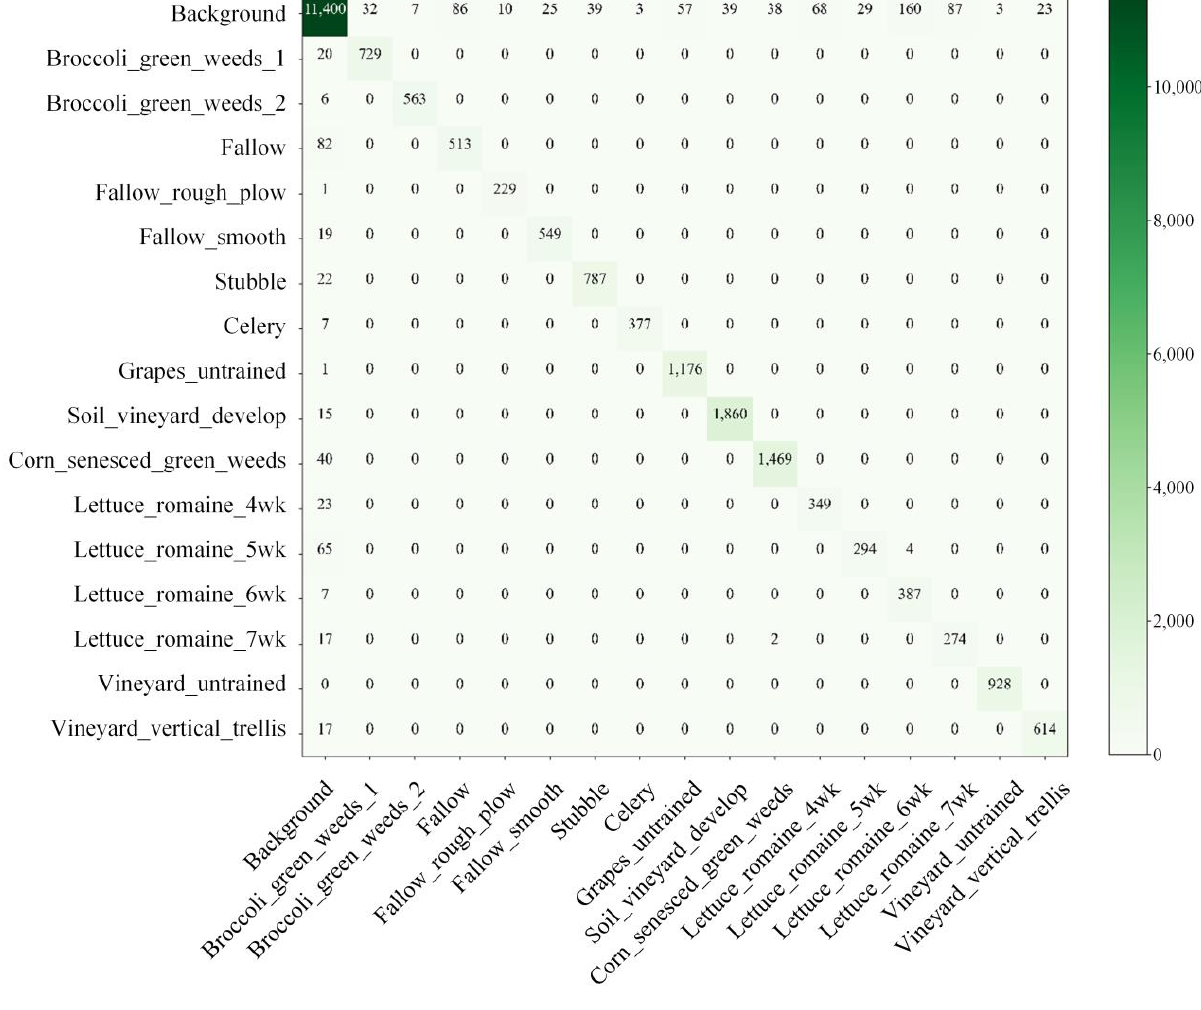
Figure 7. Confusion matrix of classification results of PSE-UNet model.